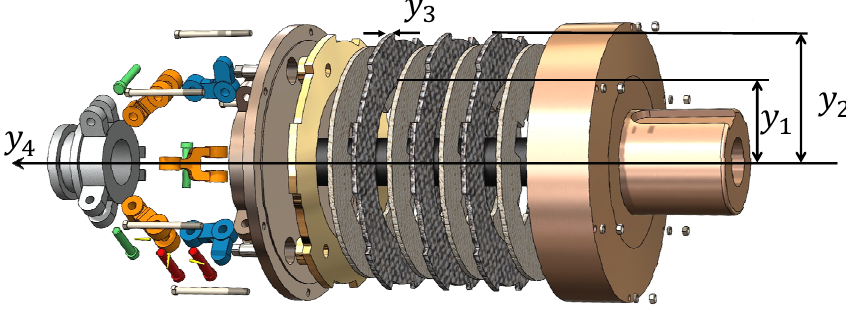
Figure 10. Multiple-disk clutch design problem. Table 9 is the optimal solution for multiple-disk clutch design obtained by 11 ad-